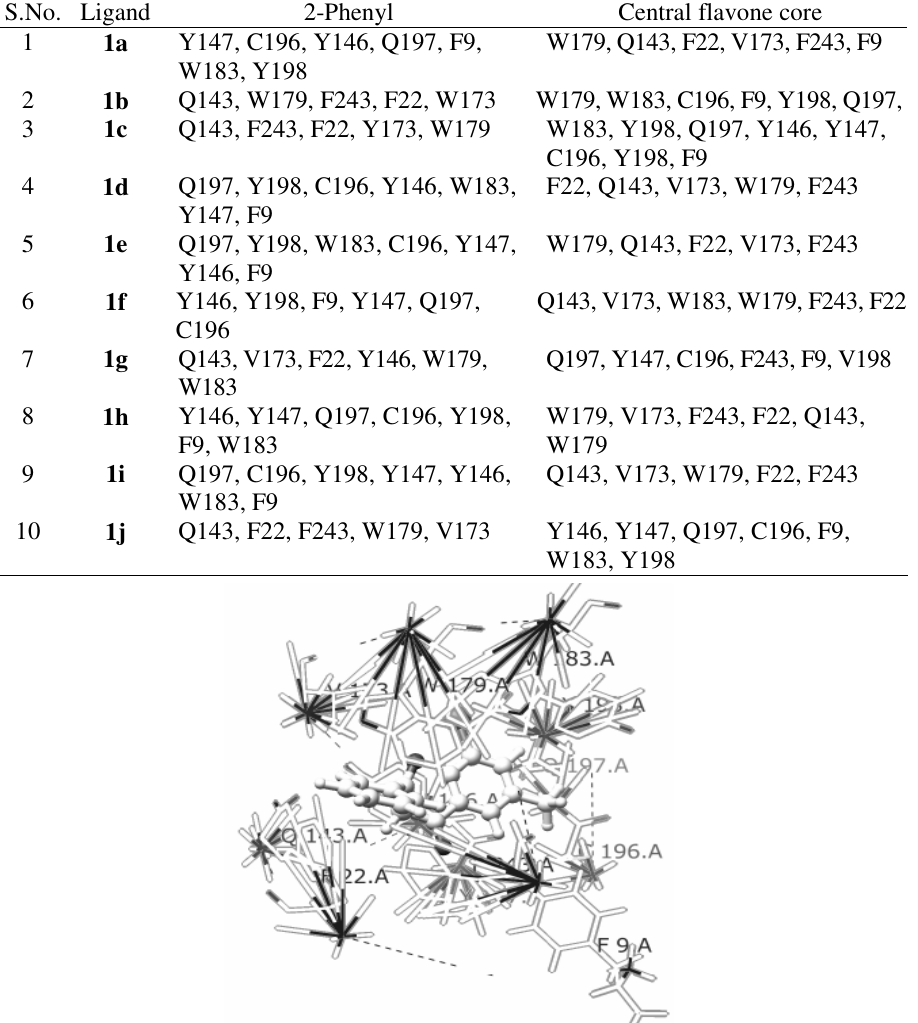
the HMT (pdb ID: 2aot) active site.